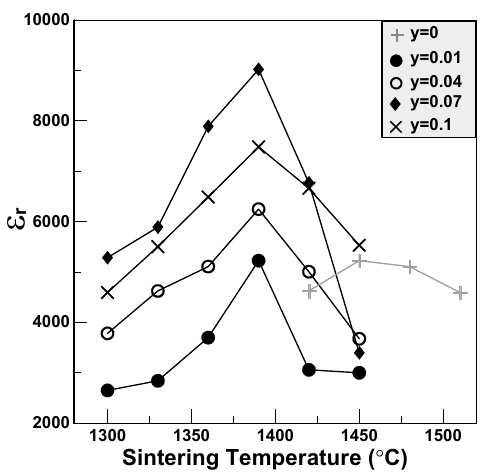
Figure 4. The dielectric constants of the BCTS–yLiF sheets.